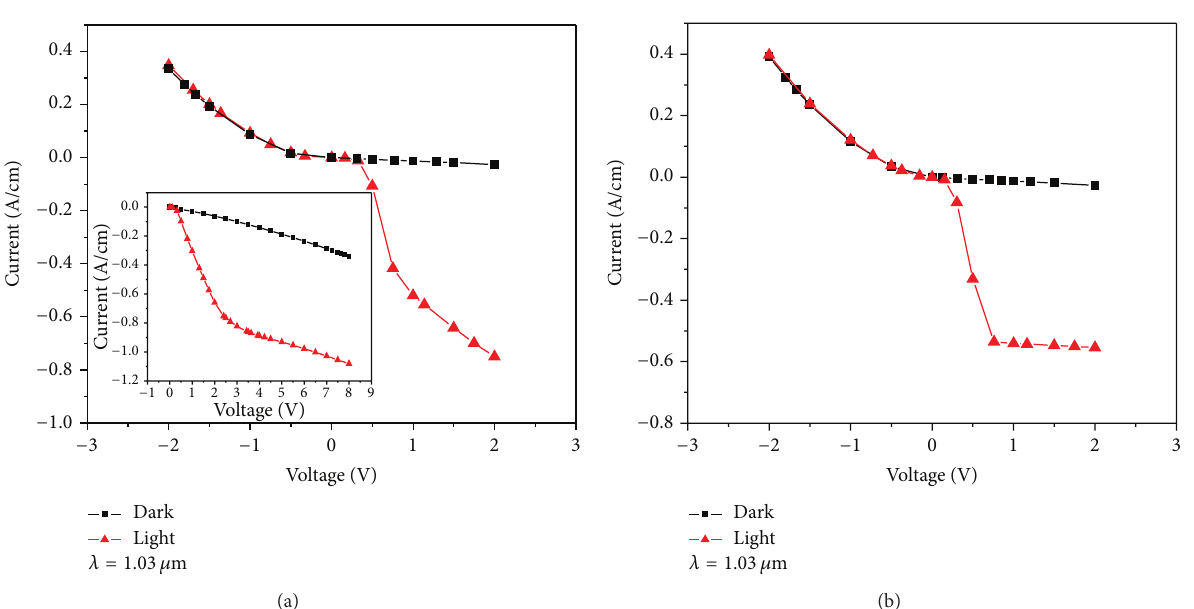
Figure 4: (a) Current-voltage characteristics of the InGaAs QD RCE photodetector. The inset shows the 𝐼 - 𝑉 characteristics at high bias voltage. (b) Current-voltage characteristics of the InAs QD RCE